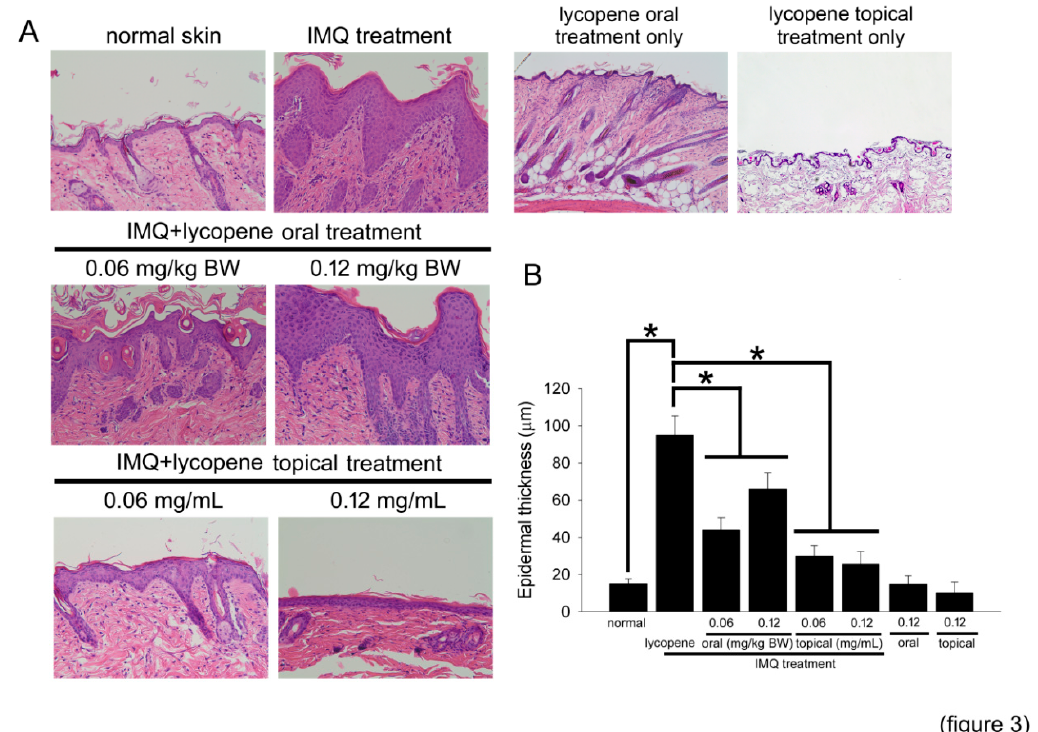
Figure 3. Lycopene inhibits epidermal hyperplasia and proliferation in IMQ-treated mice. ( A ) Structural features characteristic of IMQ-induced psoriasis-like skin were analyzed in H&E stained sections and analyzed using microscopy at 200 × magnification. ( B ) The epidermal thickness was quantified and is presented as a bar graph. The results are expressed as the mean ± SD. * p < 0.05 was considered statistically significant.